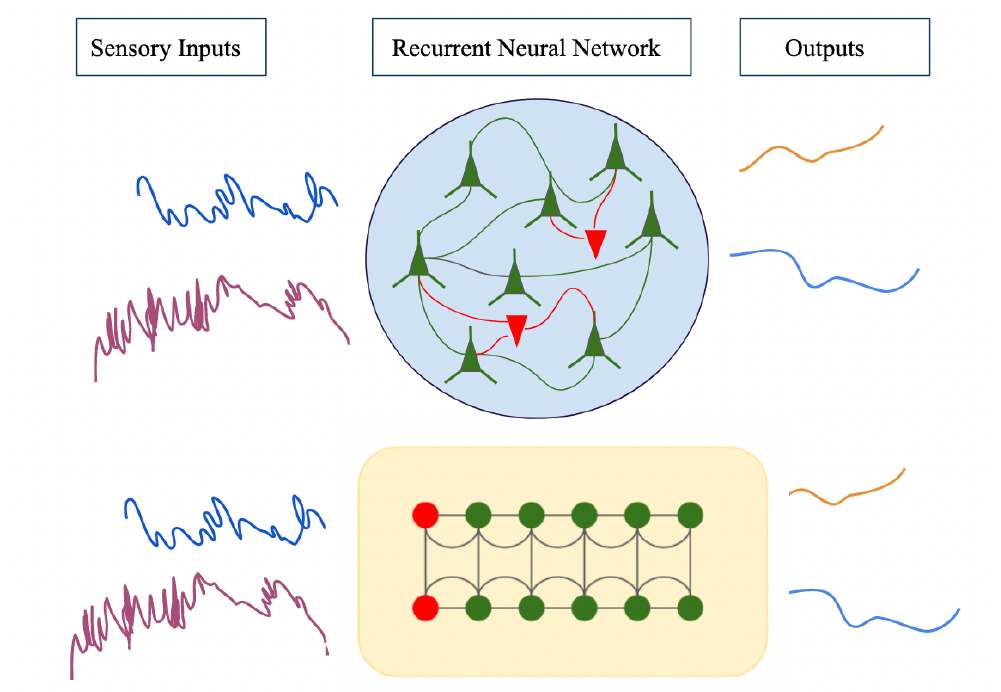
Figure 5. Schematic picture of classical recurrent neural networks (RNNs; top) and quan- tum neurons (bottom). In both cases, the inputs are some local biases, and the interneural connections have arbitrary value and a set of neurons is used for readout. Top: It is known that while many neurons are excitory with positive interaction (green), some neurons are inhibatory (red neurons) with a ratio of 1 to 4 ratio. Bottom: Quantum recurrent neural networks (qRNN) made from considering an array of atoms. In the case of the Rydberg system, one can encode the excitory and inhibitory interaction taking into account different atomic